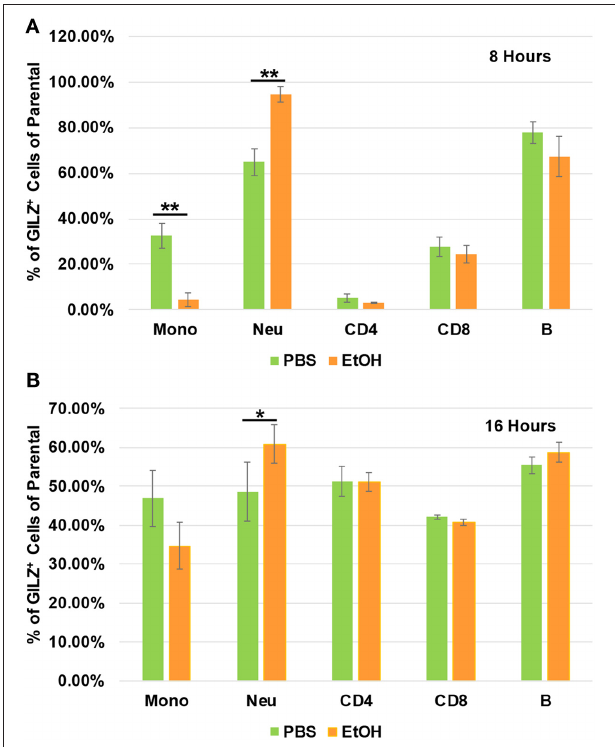
FIGURE 4 | GILZ expression in different types of immune cells. Peripheral blood WBCs from mice that had been exposed to 4 g/kg ethanol or PBS for 8h (A) or 16h (B) were isolated. Immunostainings for cell surface markers (CD11b, Ly6G, CD19, CD3, CD4, and CD8) and GILZ were performed. Monocytes (CD11b + Ly6G − ), neutrophils (CD11b + Ly6G + ), B lymphocytes (CD19 + ), CD4 lymphocytes (CD3 + CD4 + ), and CD8 lymphocytes (CD3 + CD8 + ) were categorized. GILZ-positive cells in each cell type of the parental were compared between the ethanol and control groups. Asterisks indicate statistically significant difference by student’s t -test ( n ≥ 3 per group). Mono (Monocytes); Neu (Neutrophils). * P ≤ 0.05, and ** P ≤